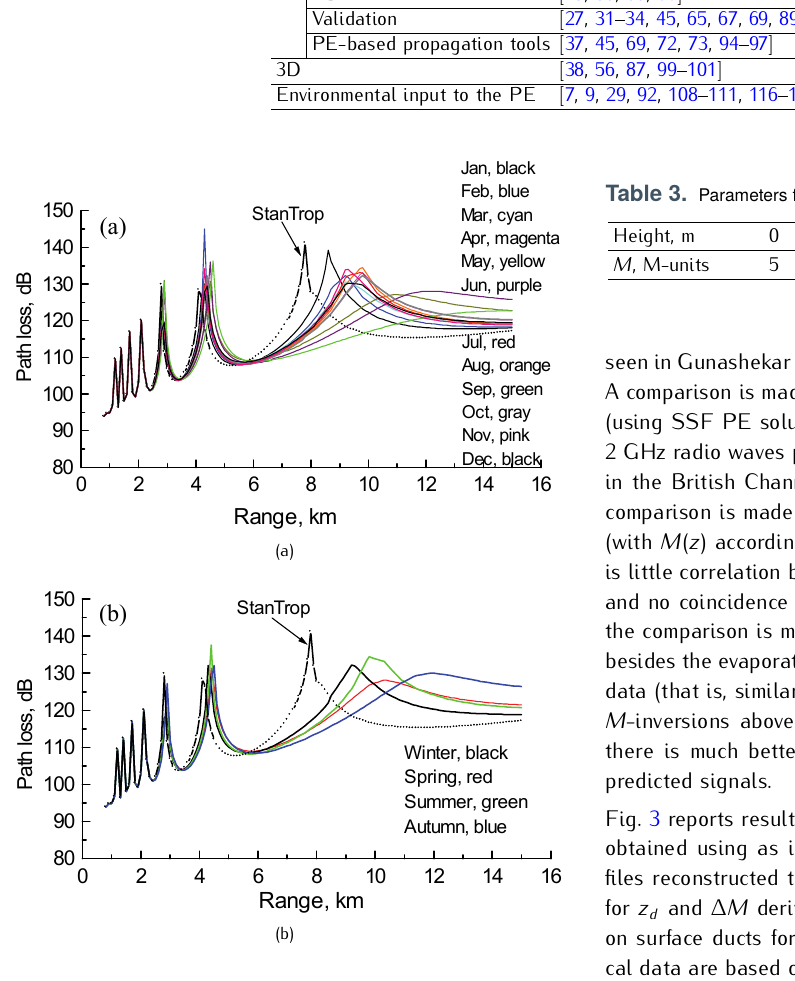
Figure 3. (a) Comparison between path losses obtained for M- profiles based on monthly mean values of duct parame- ters; (b) Comparison between path losses obtained for M- profiles for seasonal mean duct parameters.